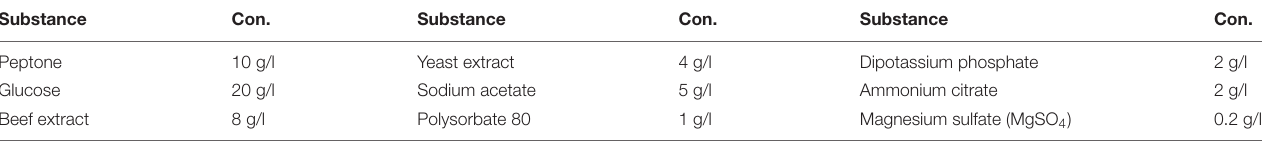
TABLE 2 | Composition of the De Man, Rogosa, and Sharpe (MRS)